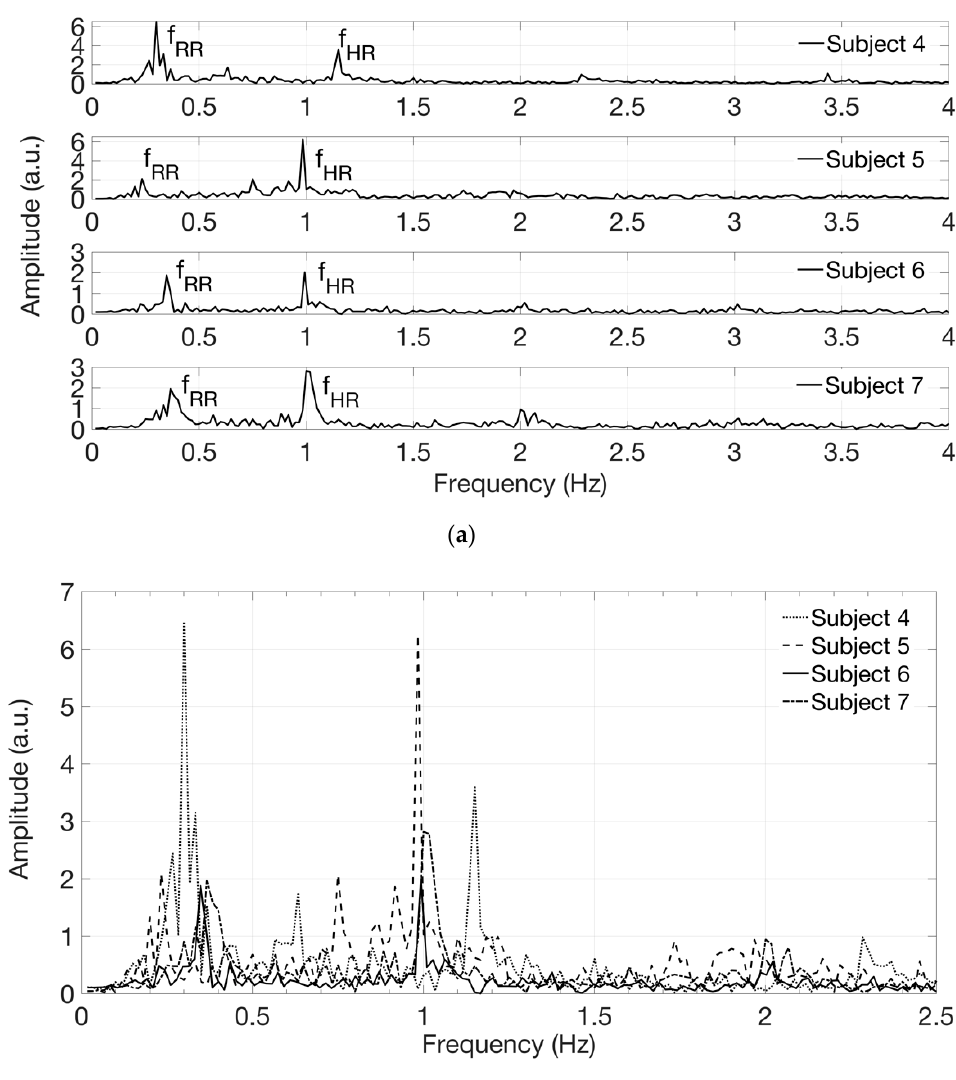
Figure 7. Signals in the frequency domain extracted from the acquired videos on white-skin, male subjects 4, 5, 6 and 7. ( a ) Spectra are reported in separate graphs for each subject; ( b ) Spectra are superimposed for comparison, on a narrower frequency range.